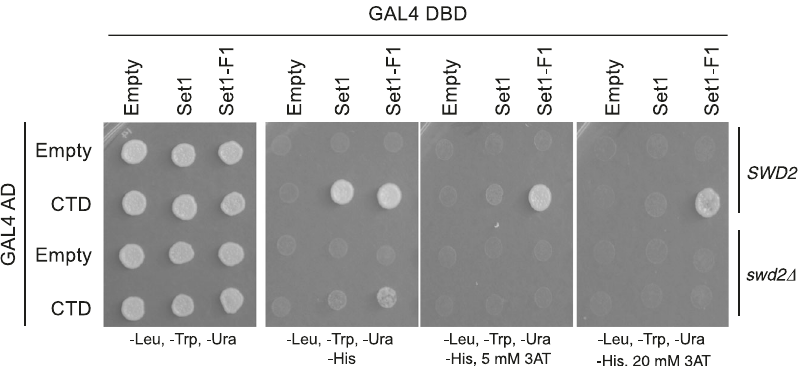
Fig. 3 Swd2 enhances the Set1 – CTD Y2H interaction. Gal4 BD fused to full length Set1 (Set1) or amino acids 1 – 236 (Set1 – F1, see Fig. 2) were expressed in Y2H strain PJ69-4A carrying wild-type ( SWD2 ) or deletion ( swd2 Δ ) alleles of SWD2 . They were combined with a Gal4 AD fusion to the Rpb1 CTD (CTD) or the parent vector (Empty). Cells were spotted on the indicated selective plates. Source data are provided as a Source data fi